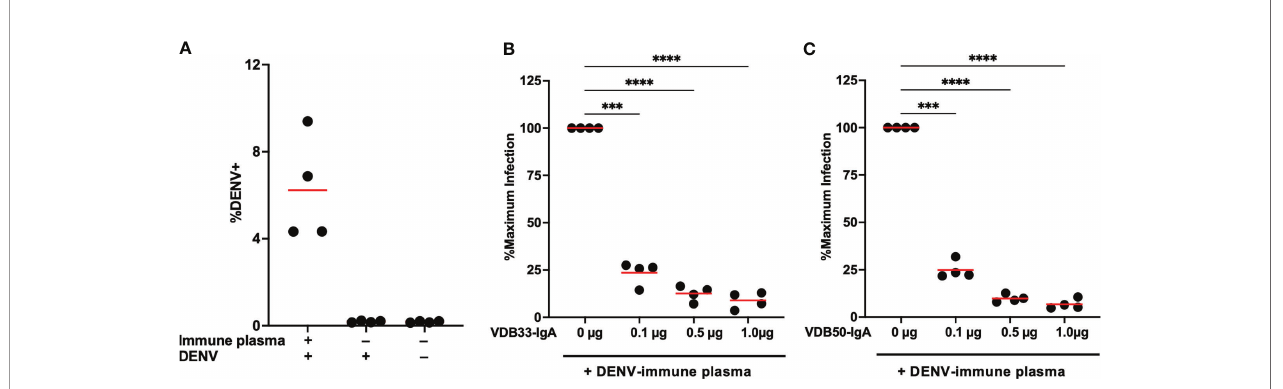
FIGURE 4 | Monoclonal IgA antagonizes ADE mediated by polyclonal DENV-immune plasma. (A) DENV immune plasma enhances DENV-3 infection of K562 cells. Each datapoint represents a unique plasma donor (n = 4). (B) VDB33-IgA antagonizes in vitro enhancement of DENV-3 infection mediated by polyclonal DENV- immune serum. Serum used at a 1:50 dilution for ADE assay, n = 4 unique plasma donors. The percentage of DENV-positive cells was normalized to that observed in the plasma-only condition. (C) VDB50-IgA antagonizes in vitro enhancement of DENV-3 infection mediated by polyclonal DENV-immune serum. Serum used at a 1:50 dilution for ADE assay, n = 4 unique plasma donors. The percentage of DENV-positive cells was normalized to that observed in the plasma-only condition. ***p < 0.001, ****p < 0.0001 1-way ANOVA with Dunnett correction for multiple comparisons. Data are representative of at least 4 independent